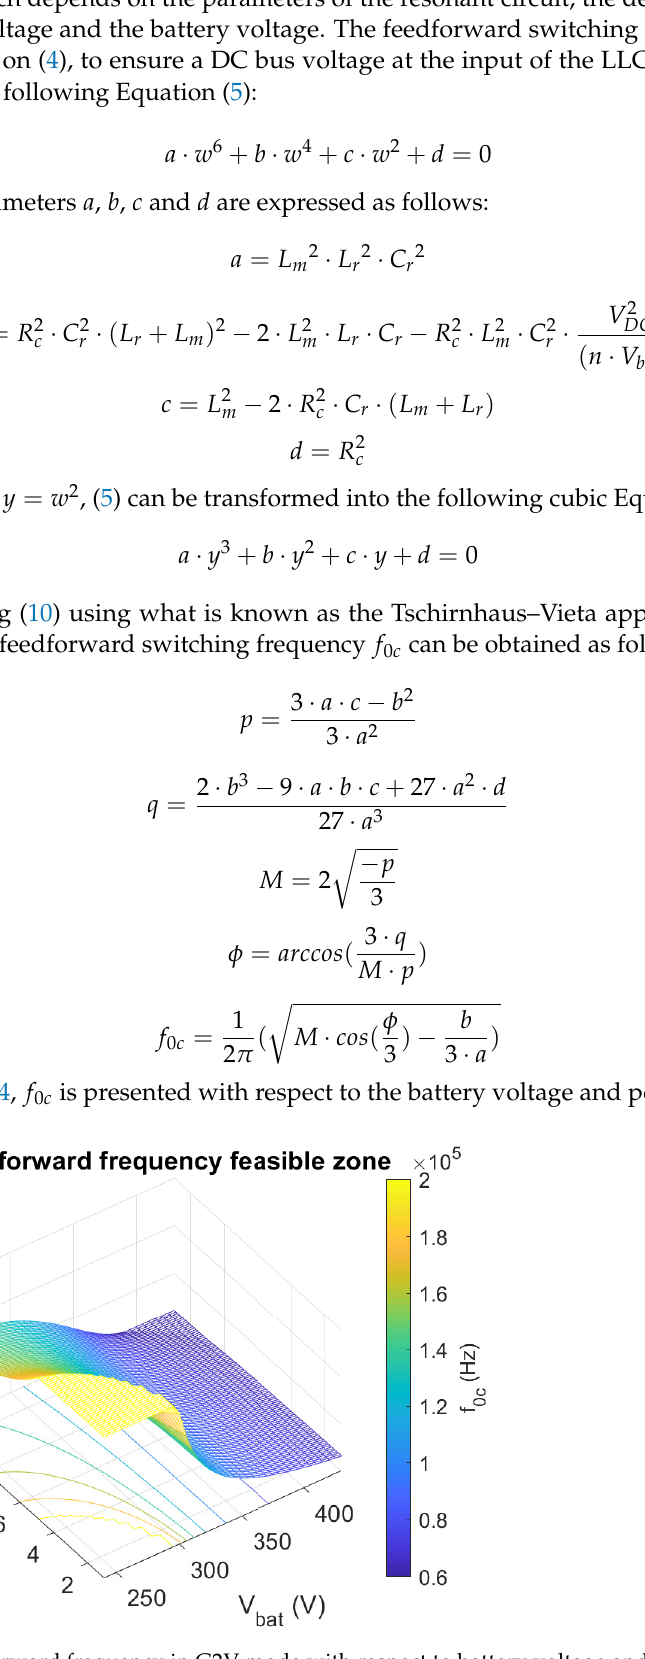
Figure 4. Feedforward frequency in G2V mode with respect to battery voltage and power